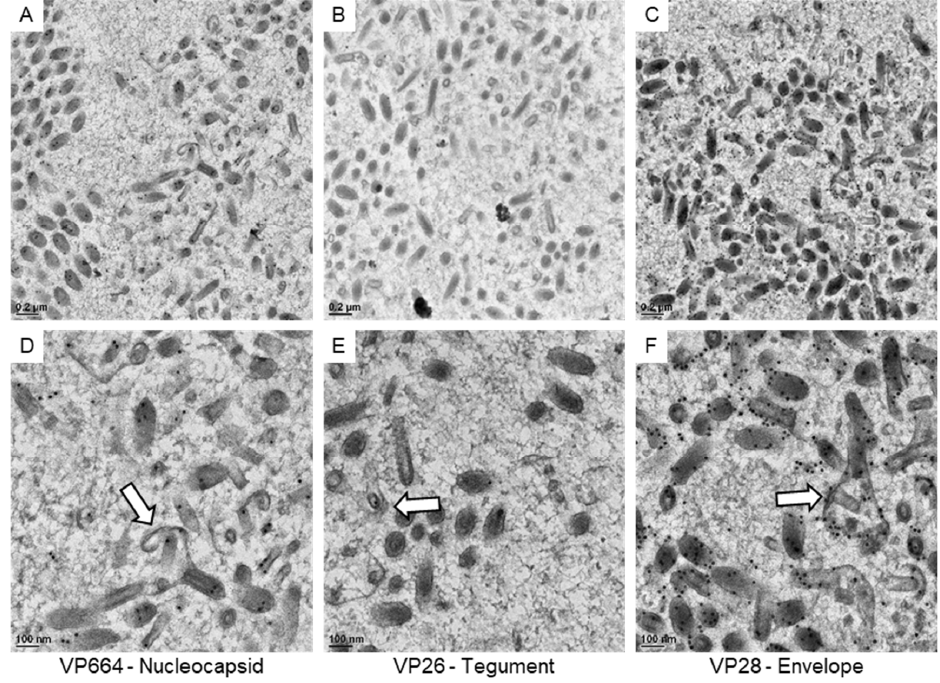
Figure 6. The expressions of viral proteins on the assembling WSSV particles. The represented im- ages show the immuno-gold labeling of the nucleocapsid protein VP664 ( A ), the tegument protein VP26 ( B ), and the envelope protein VP28 ( C ) in the area containing assembling particles. ( D – F ): The high magnification view of assembling particles (the white arrows) found in the area of ( A – C ), re- spectively.